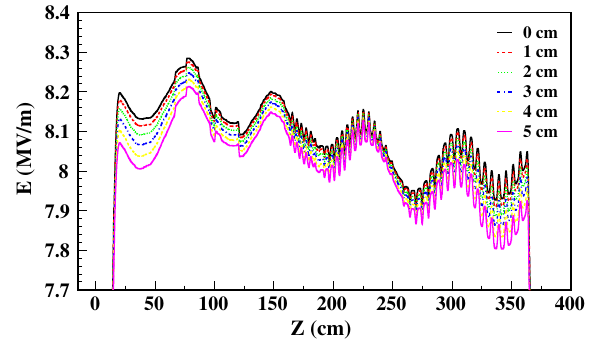
FIG. 19. Intervane electric field along the RFQ for different uniform tuner’s depth.